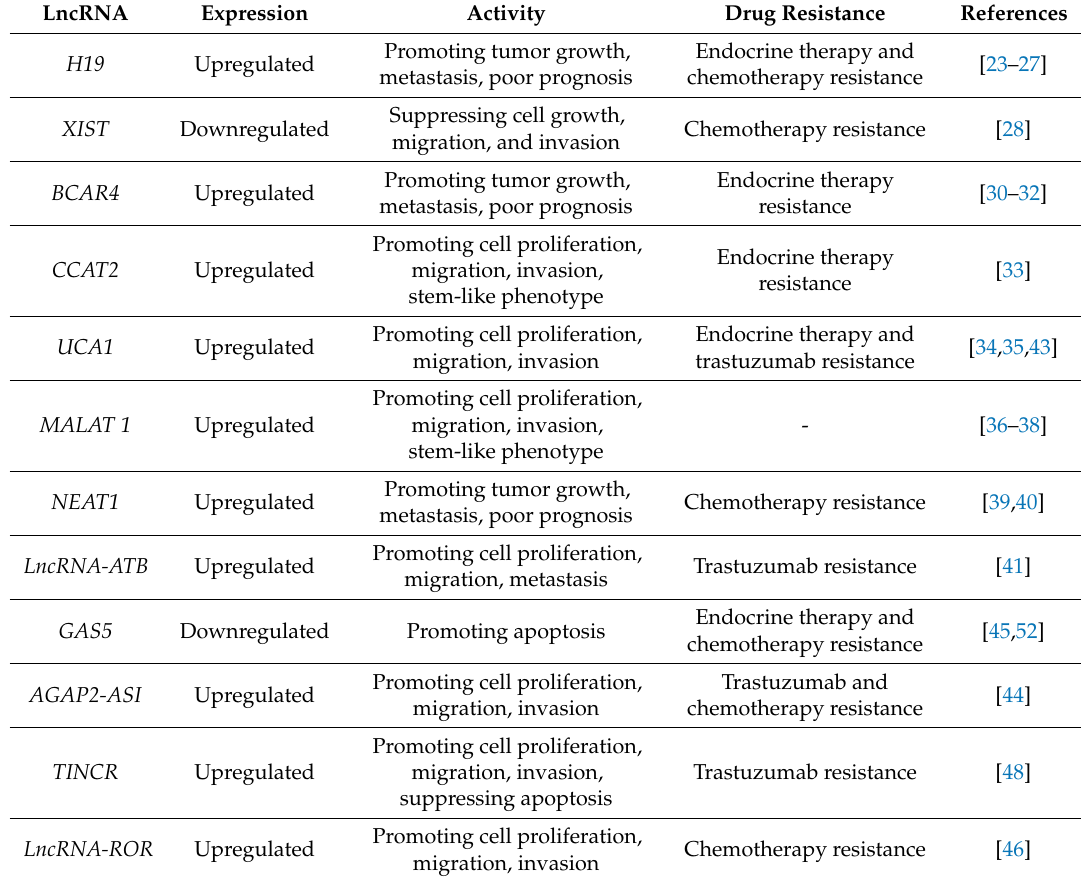
Table 1. Main lncRNAs (long non-coding RNAs) involved in BC (breast cancer) progression. LncRNA